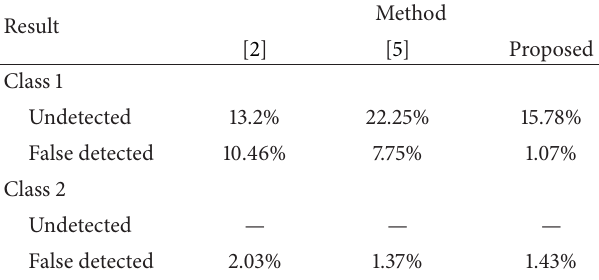
Table 4: The comparison of